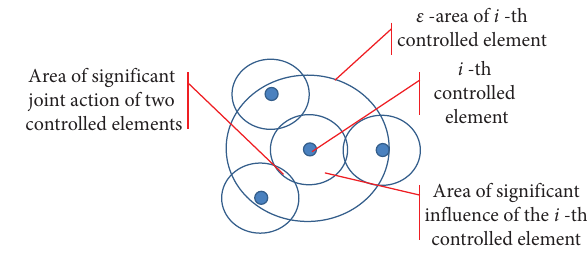
Figure 2: Determination of heaters ε